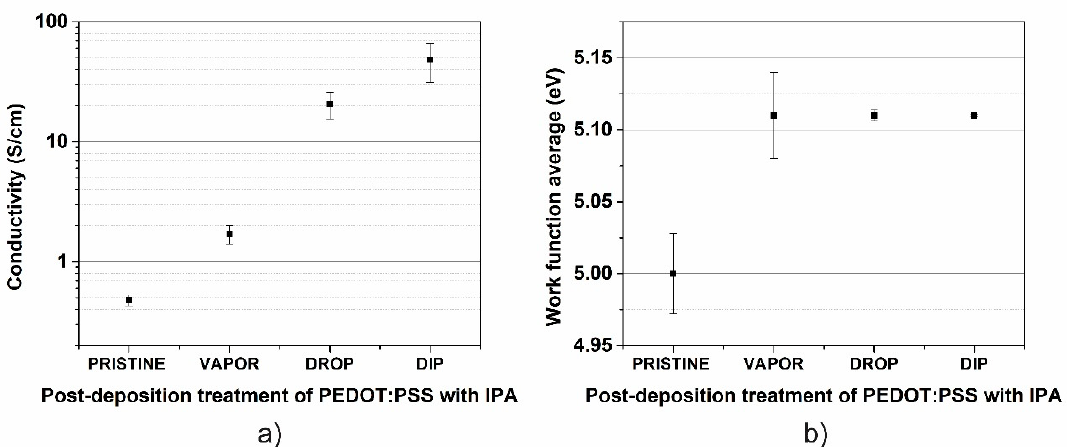
Figure 6. ( a ) Electrical conductivity and ( b ) work function of pristine PEDOT:PSS film and post-treated IPA PEDOT:PSS films using VAPOR, DROP, and DIP techniques. Polymers 2019 , 11 , x FOR PEER REVIEW